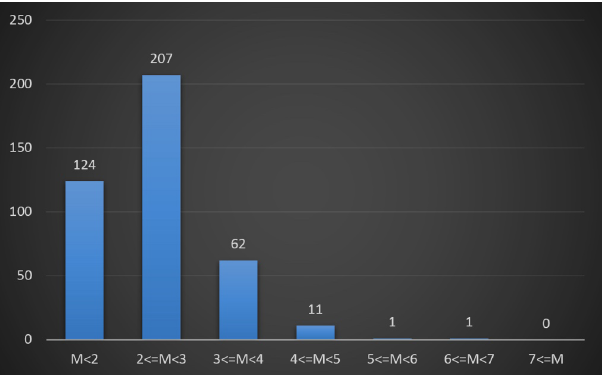
Figure 1. Graphical distribution of aftershocks (URL-1)